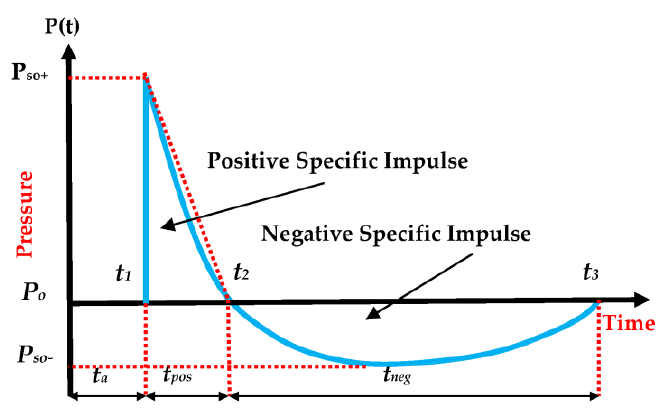
Figure 1. Typical pressure-time history from air explosions [17,47–50]. This curve represents the change in the pressure versus time at any location away from the center of the explosion. Where “ P SO ” represents the peak incident pressure, “ P O ” represents the ambient atmospheric pressure, “ P − SO ” represents the negative pressure and “ t a ” is the arrival time. The blast wave reaches the structure according to the